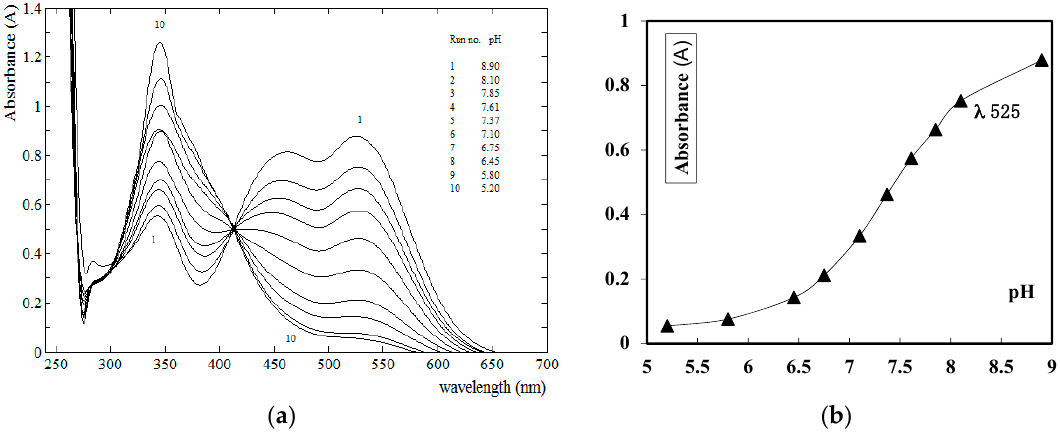
Figure 1. ( a ) UV absorption spectra of ( 6e ), in solution of different pH values (80% dioxane-water) at 27 °C and μ = 0.10; ( b ) Spectrophotometric titration curve of ( 6e ), at λ max = 525 nm in 80% dioxane-water mixture at 27 °C and μ = 0.10.